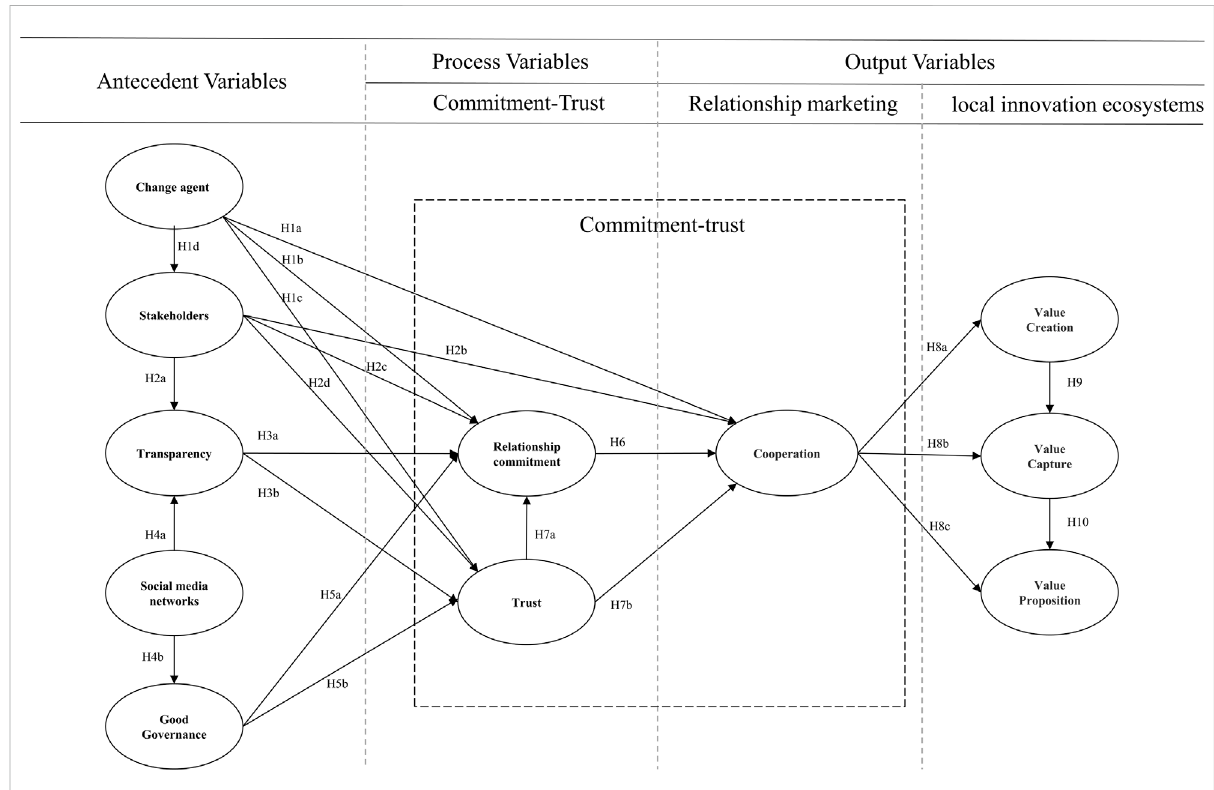
FIGURE 4 Proposed research model: A community sustainability ecosystem